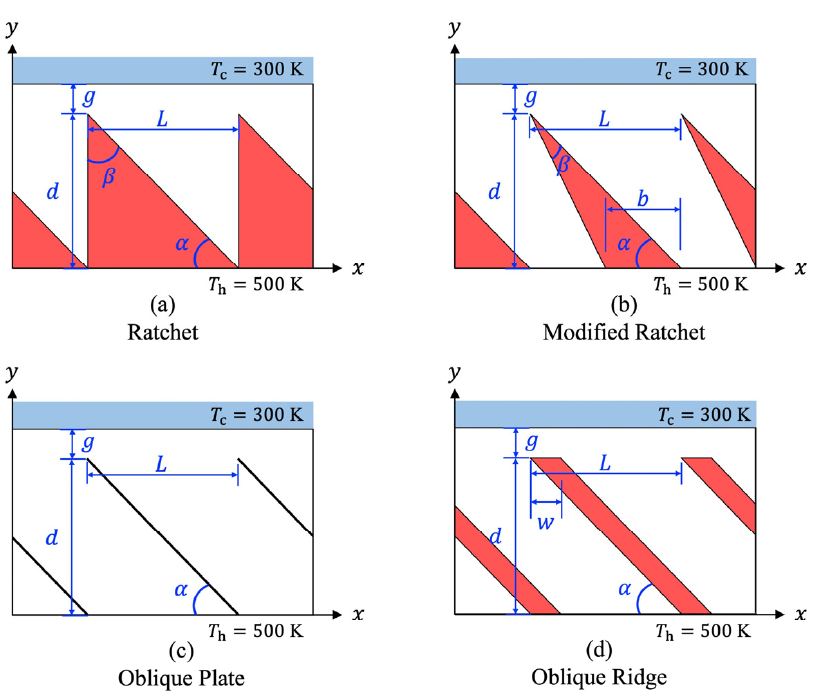
Figure 1. Schematics of the substrate with different surface microstructures.